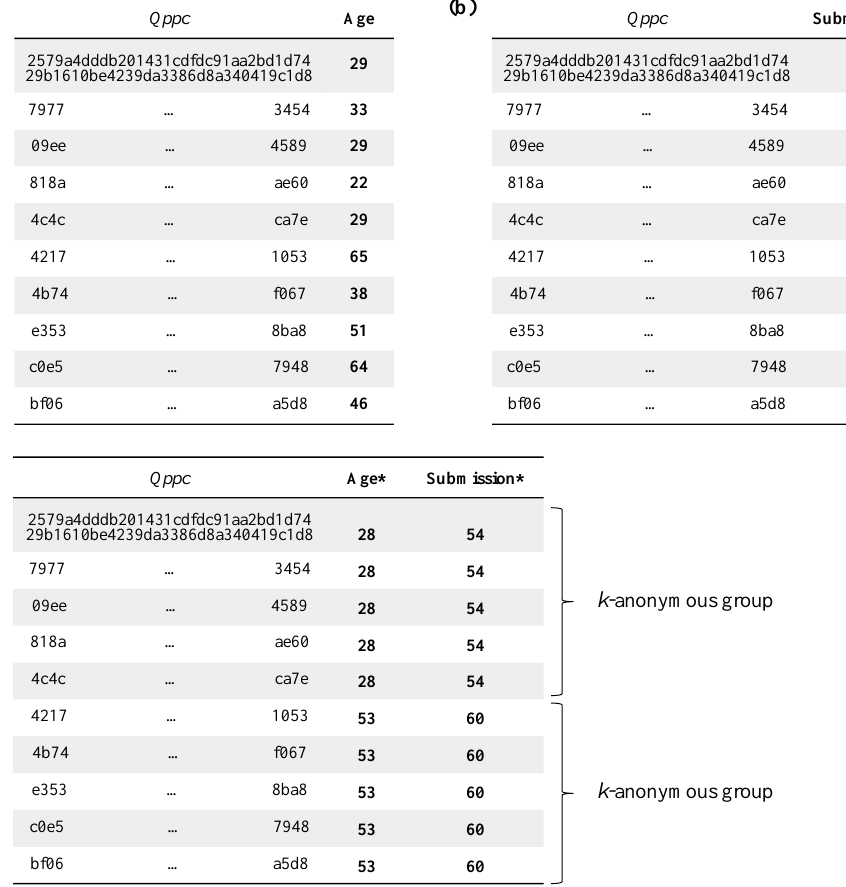
Figure 3. ( a ) Data partition sent by the provider P a during the quasi-identifier collection (step 4 of the protocol). ( b ) Data partition sent by the provider P b during the quasi-identifier collection (step 4 of the protocol). ( c ) k -anonymized and integrated quasi-identifiers with k = 5 (steps 5 and 6 of the